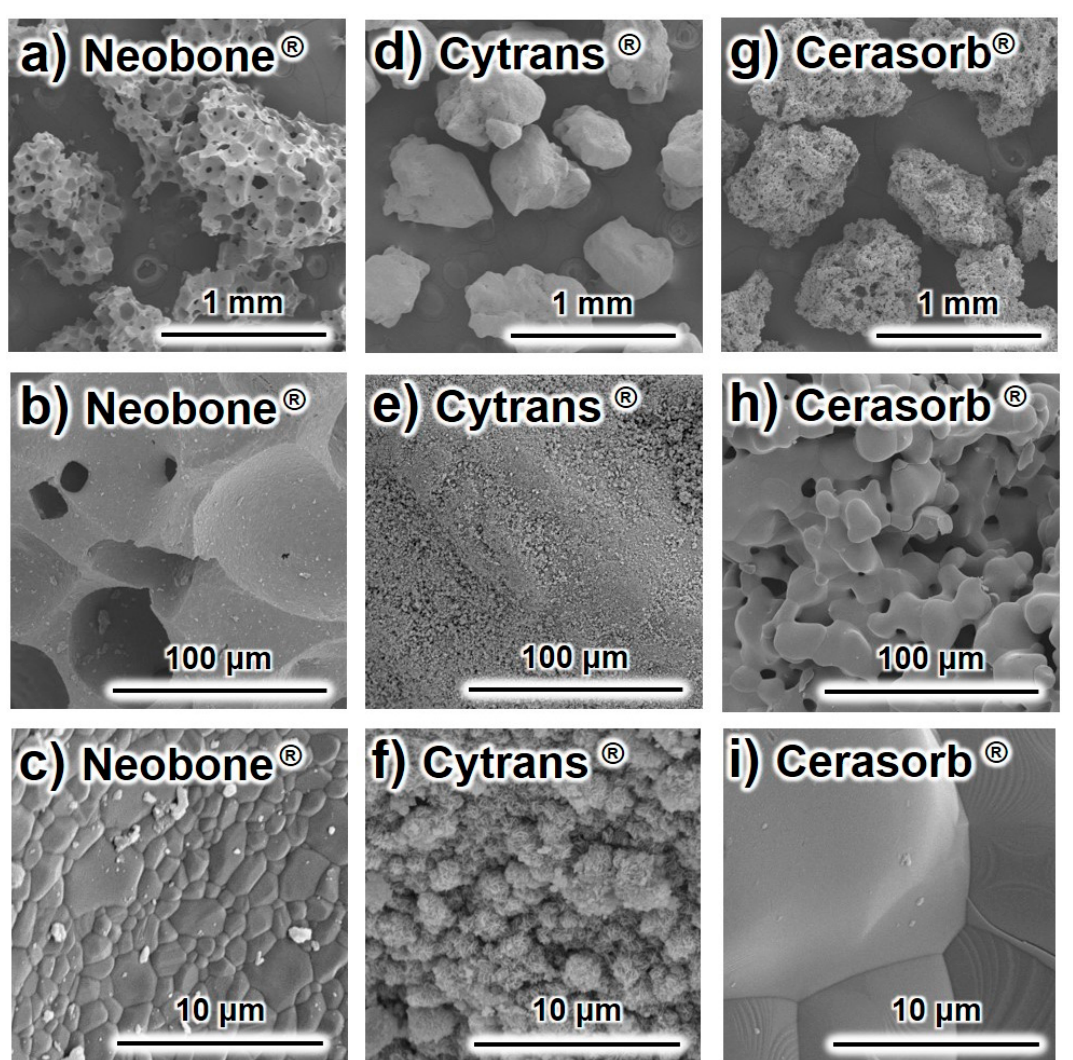
Figure 1. Typical scanning electron microscopy images of Neobone ® (HAp) ( a – c ), Cytrans ® (CO 3 Ap) ( d – f ), and Cerasorb ® ( β -TCP) ( g – i ). ( d – f ), and Cerasorb ® ( β -TCP) ( g – i